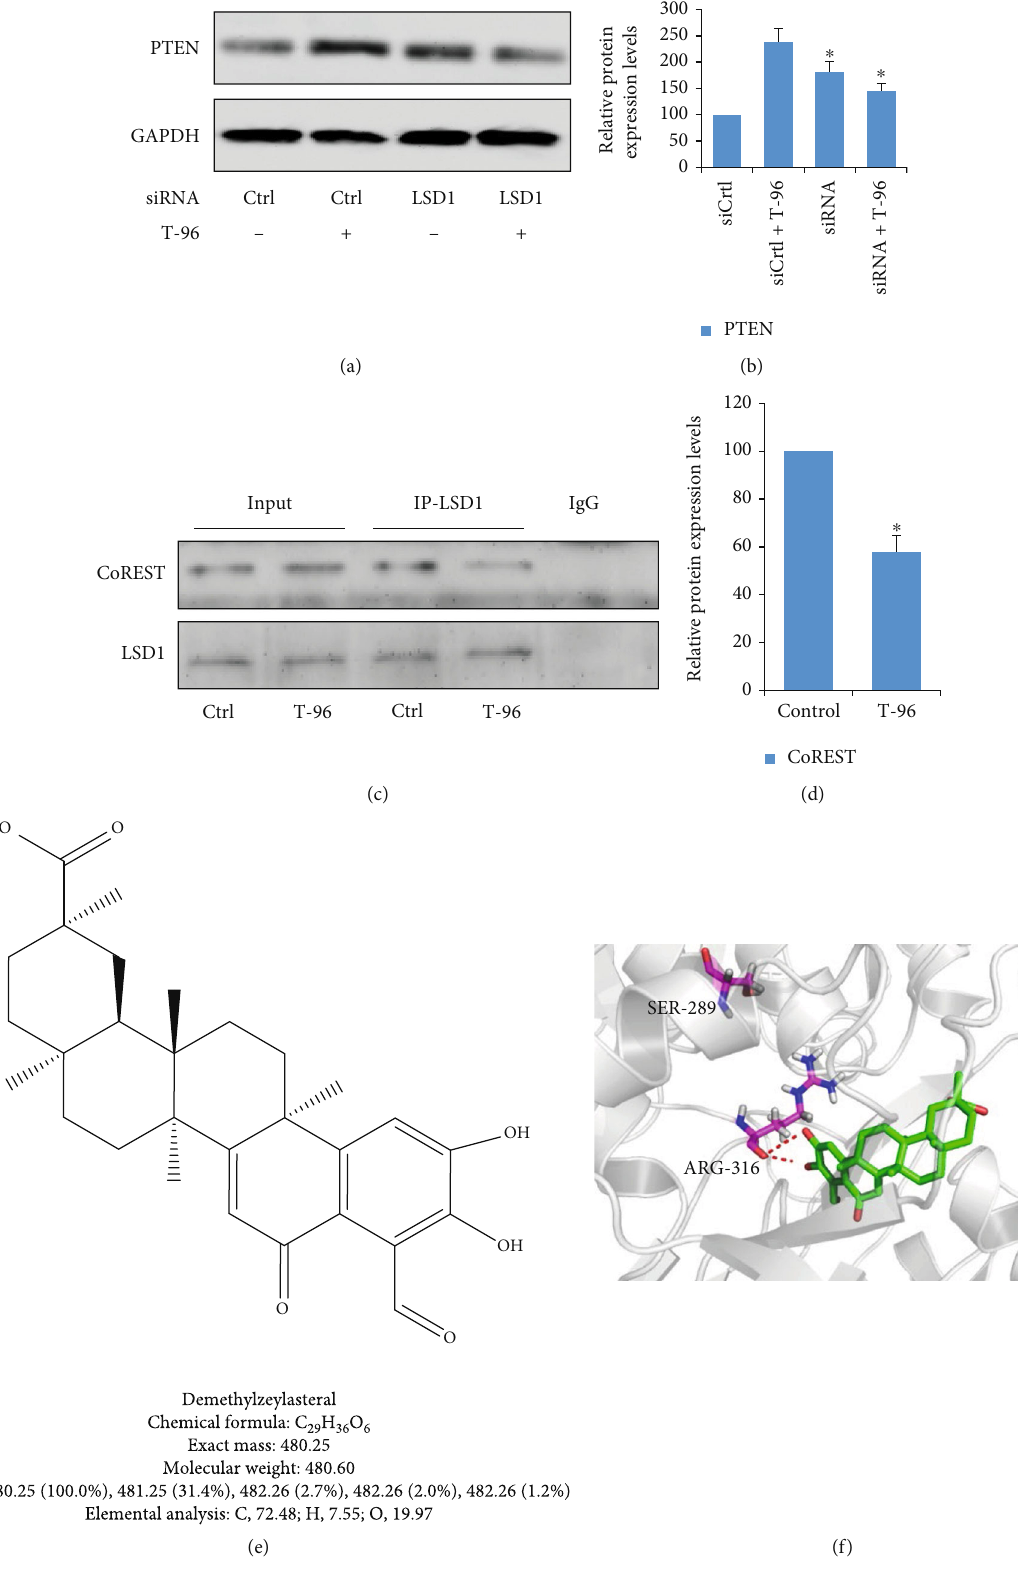
Figure 4: T-96 inhibited LSD1-mediate cell signal in the highly metastatic breast cancer cell SUM-1315. (a, b) LSD1 siRNA attenuated T-96 inhibited LSD1 pharmacological activity; (c, d) LSD1 inhibited CoREST/LSD1 protein-protein interaction by Co-IP assay. (e) Chemical structures of T-96; (f) the binding mode of T-96 bounded with the pocket of LSD1. Values are statistically signi fi cant at ∗ P < 0 : 05